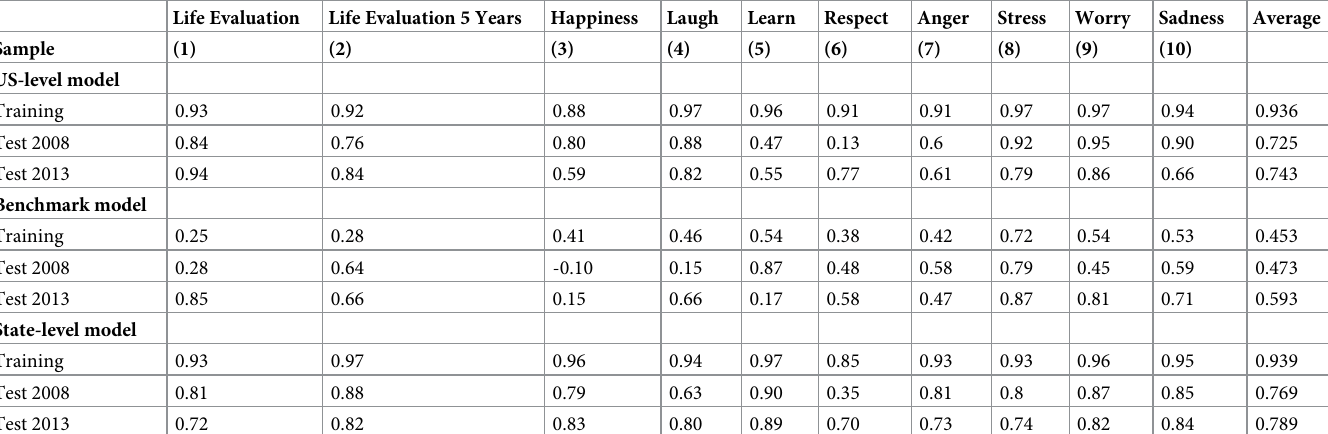
Table 6. Correlation between predicted and observed subjective well-being